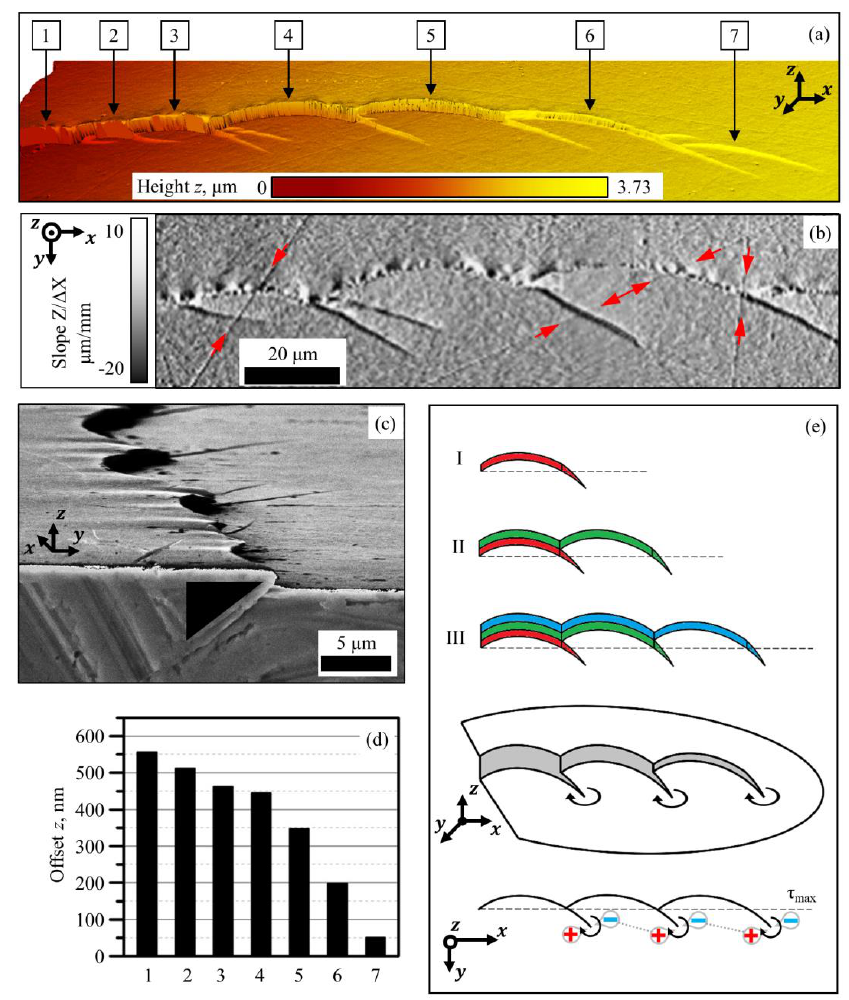
Figure 3. The typical behaviour of the mode III shear band (SB) in the compressed Pd-based bulk metallic glass (BMG) specimen. The 3D surface map obtained with the scanning white-light interferometry (SWLI) technique ( a ) shows a segmented nature of a mode III shear (275 µ m length). The slope map reveals fine scratches (marked by red arrows) extending through SBs and showing the absence of a mode II shear component ( b ). The scanning electron microscope (SEM) image of the mode III SB shows 40 ◦ inclination to the surface ( c ). Shear o ff sets 1 to 7 measured by SWLI are represented on the bar chart ( d ). The schematic ( e ) illustrates a dislocation-based interpretation of the shear morphology formed in three consecutive steps I, II, and III, and the corresponding isometric and top views of the resulting shear. In this case, the circled arrows indicate the positions of screw dislocation lines, and the “plus” / “minus” signs indicate the tensile and compressive stress components of a macro-dislocation,